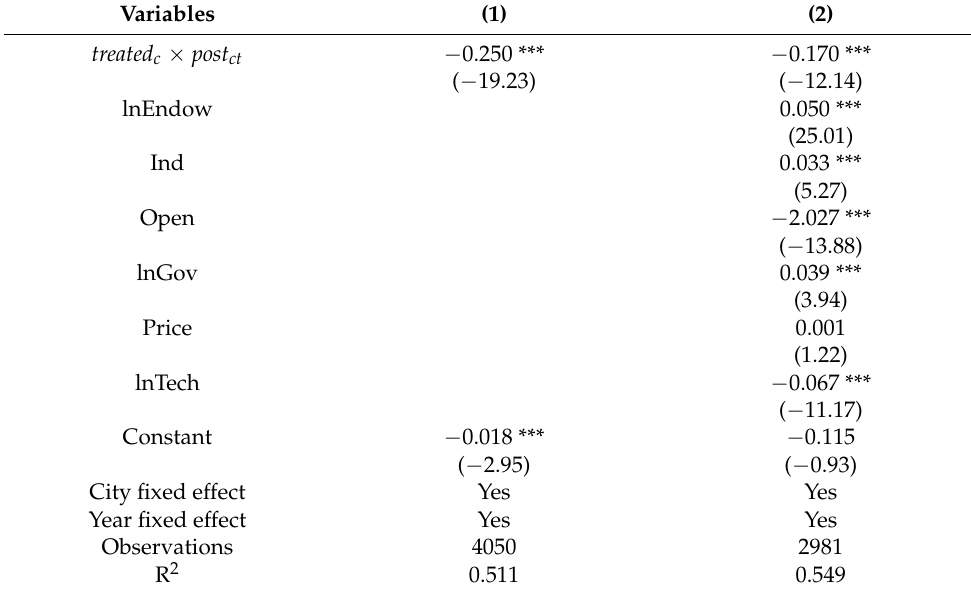
Table 2. Baseline regressions.